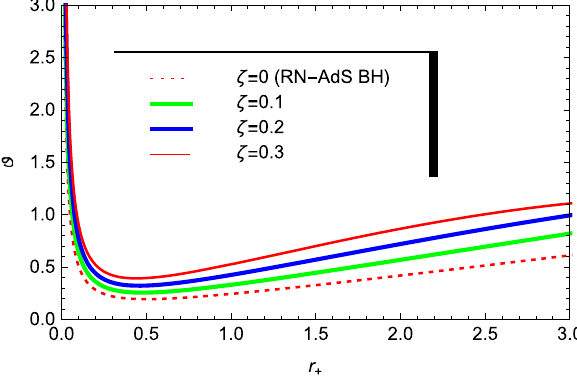
Fig. 6 Plot of the temperature w.r.t horizon radius r + for l 2 = 675